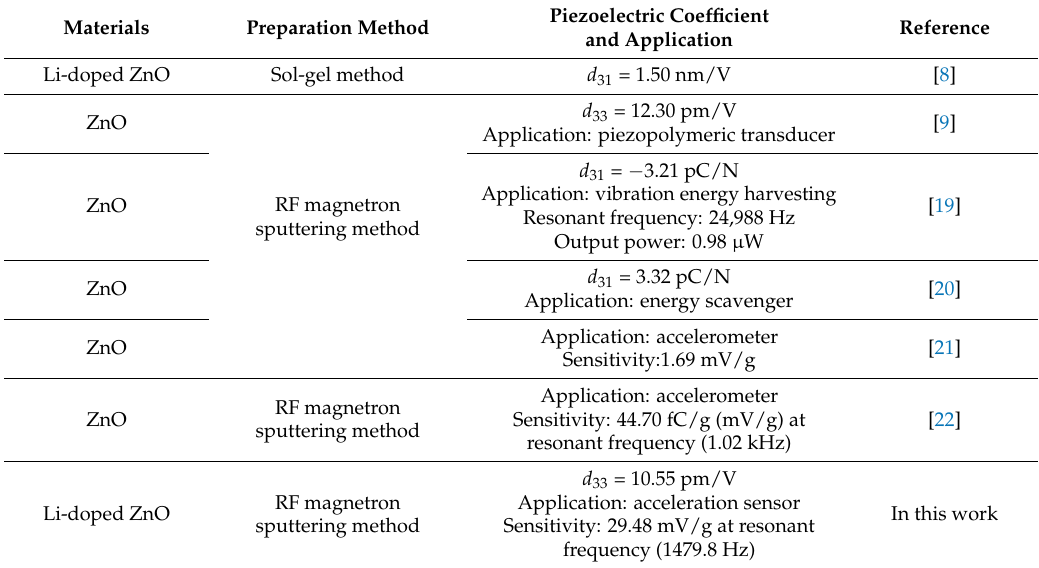
Table 1. The preparation method, piezoelectric coefficient, and application of the ZnO piezoelectric thin